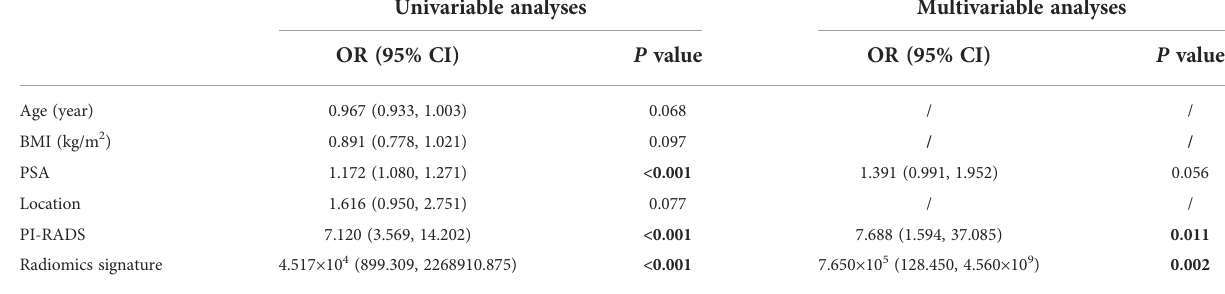
TABLE 3 Univariate and multivariate logistic regression analyses in the training set.